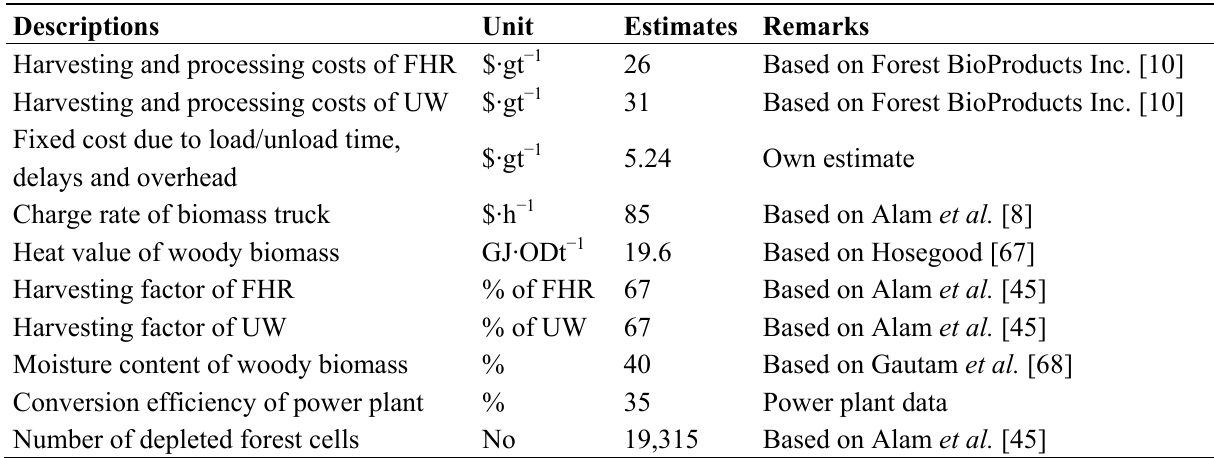
Table 1. Estimates of parameters used in BASE scenario of the